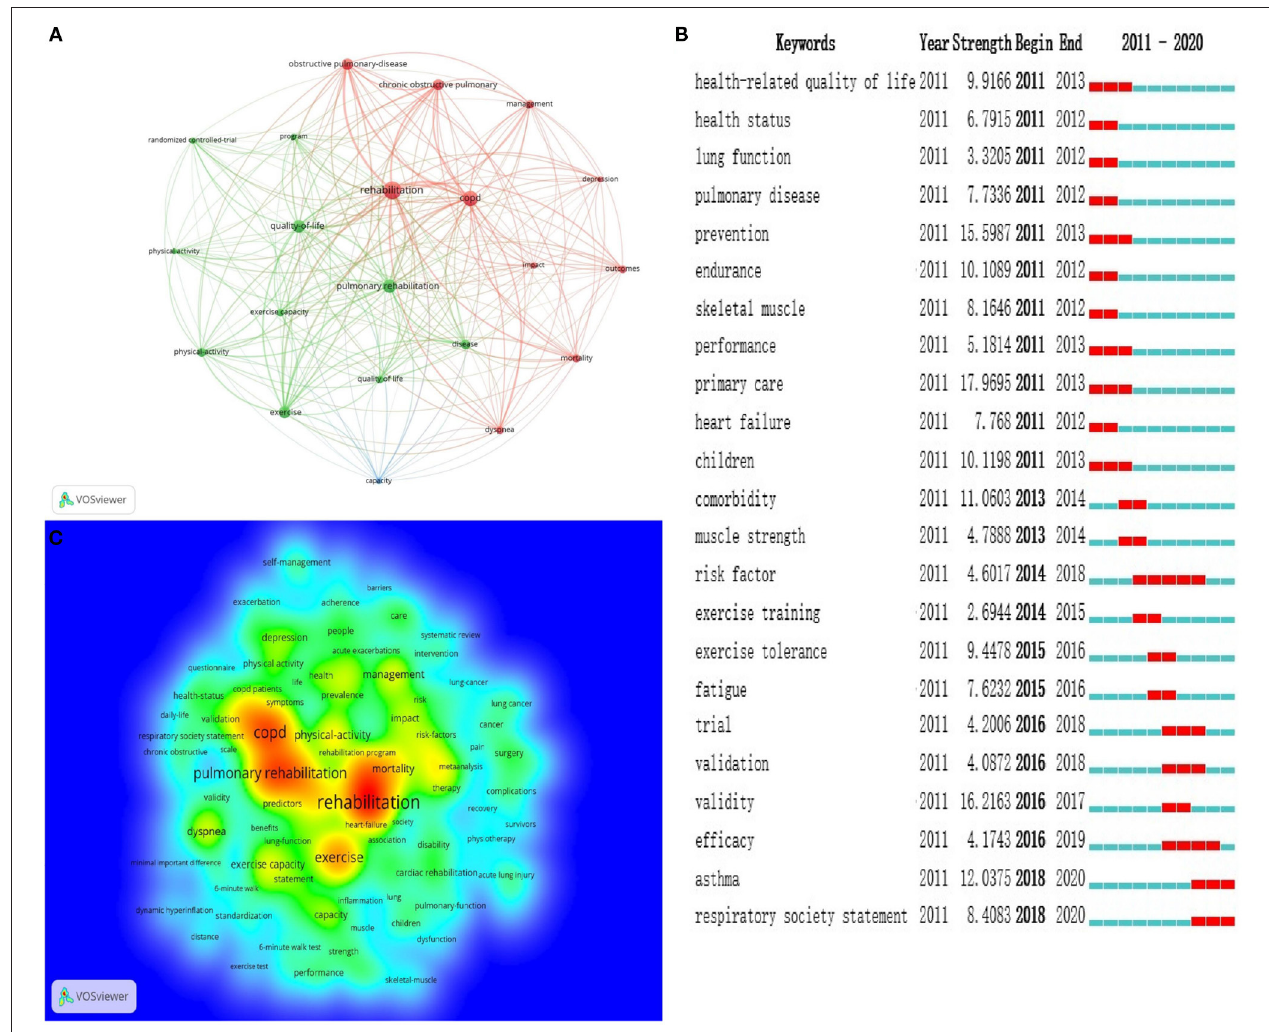
FIGURE 8 | (A) Map of keywords co-occurrence related to pulmonary rehabilitation from 2011 to 2020 (T ≥ 200). (B) Top 20 Keywords with the Strongest Citation Bursts. (C) The density map of keywords, in which the closer the keyword node color is to red, the higher the frequency of its